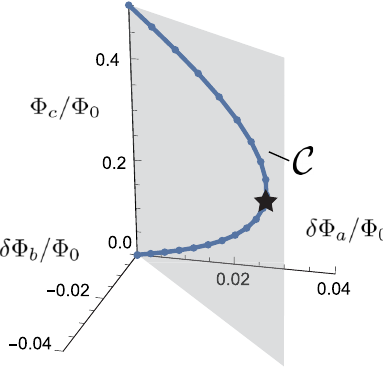
FIG. 3. The sweet-spot contour. As the coupler flux is tuned, the qubit fluxes must be simultaneously adjusted according to /(cid:3) = ( − 1 ) μ + 1 (cid:6) 0 | θ | 0 (cid:5) / 4 π in order to keep the qubits at δ(cid:3) μ − − − 0 their sweet spots (cid:11) μ = 0. The qubit fluxes are measured as devi- ations away from the bare sweet-spot locations. The sweet-spot contour C lies in the semitransparent gray plane, which bisects the angle between the two qubit-flux axes. The off position where (cid:11) = J = 0 is marked by a black μ